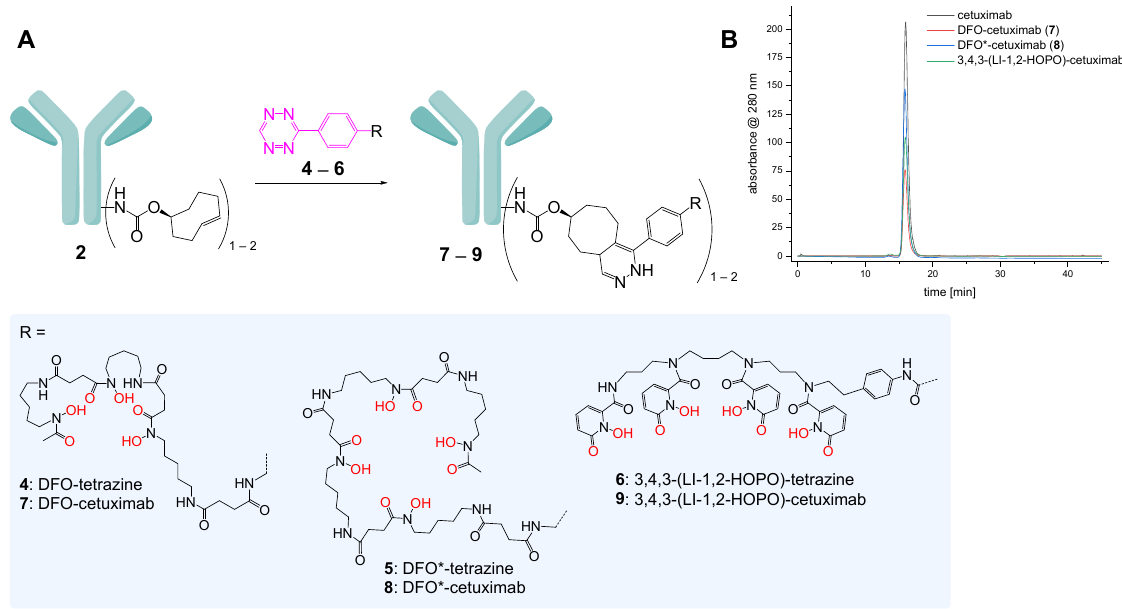
Figure 3. Schematic depiction of the preparation of the chelator-cetuximab-bioconjugates 7 – 9 from cetuximab-TCO 2 and the chelator-tetrazines 4 – 6 ( A ) and size-exclusion HPLC analyses of cetuximab and its chelator-modified analogs 7 – 9 ( B ).